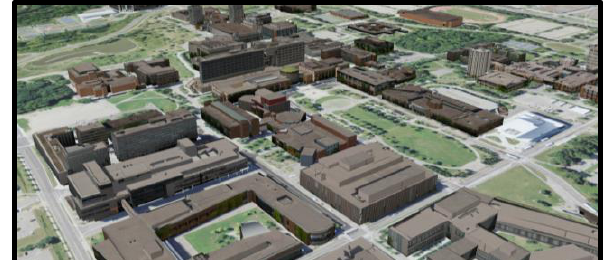
Figure 2: York University's 3D virtual campus model 5.